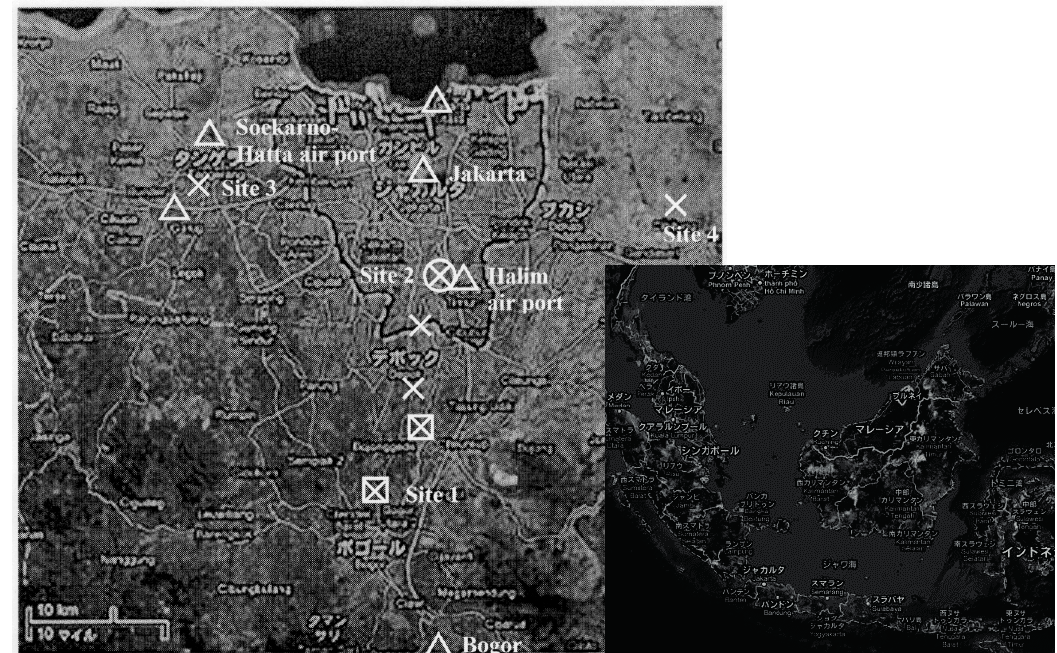
Fig. 2 Sites for the fixed-point observation. Cross marks indicate thermo-hygrometers, squares indicate aerovanes, and the circle indicates a thermometer. The triangles indicate observatories in NOAA’s National Climatic Data Center (NCDC). Google Maps (http://maps.google.co.jp/maps) was used to create this